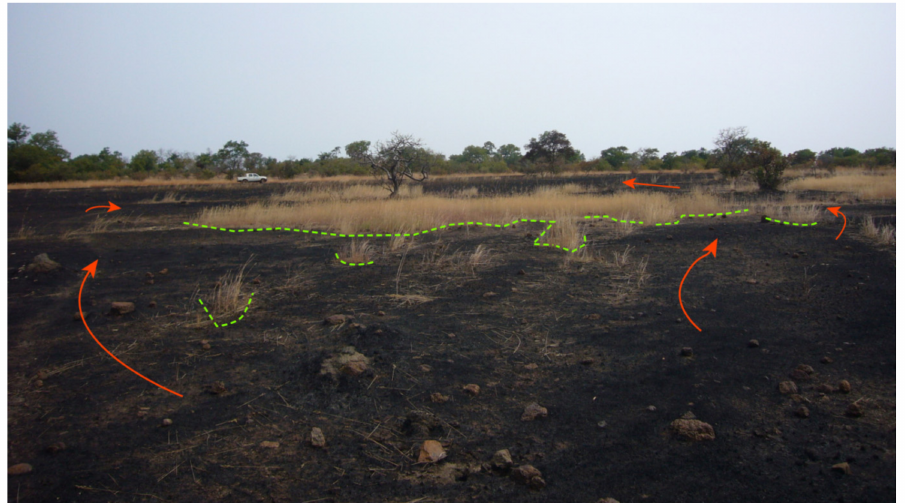
Figure 1. Burned areas on bow é , grasses are a ff ected by slow creeping fire, and trees are not